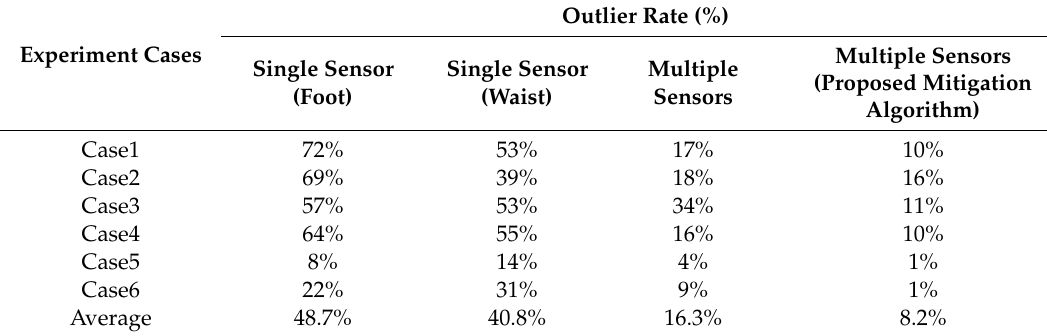
Table 4. Comparison of outlier rates.